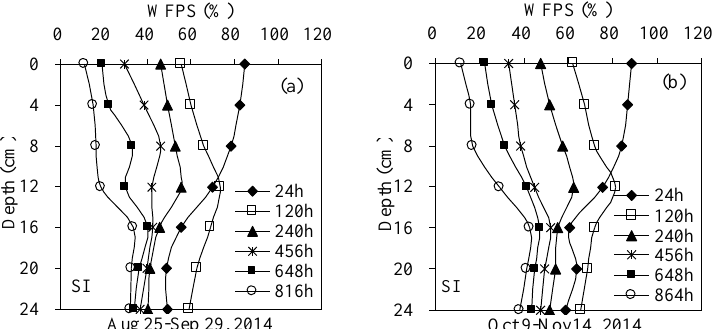
Figure 2. Soil moisture from surface irrigation (SI) treatment at different depths after the first ( a ) and second ( b ) irrigation.